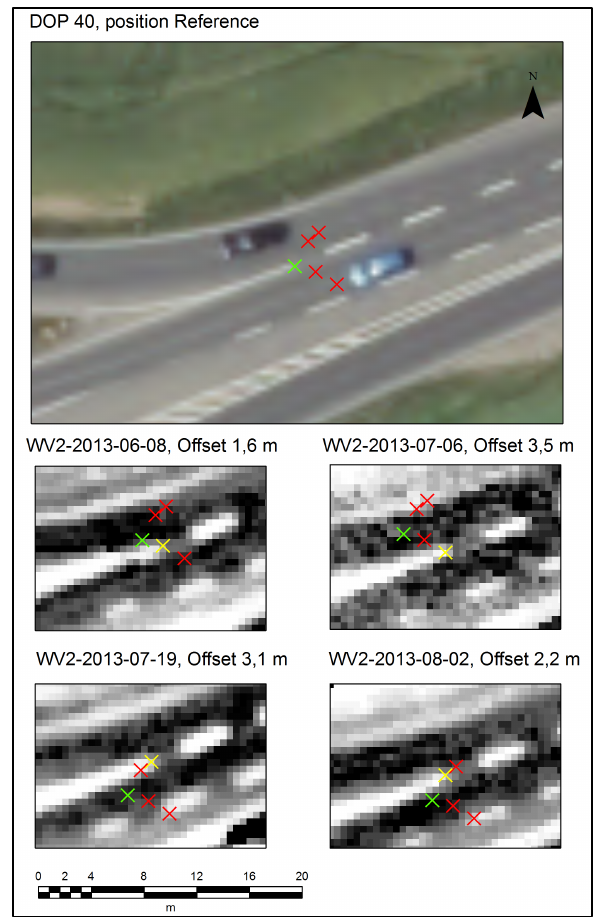
Figure 5. Accuracy checkpoint 5 and its position in the 4 satellite scenes. The total offset distance is always less than 2 multispectral